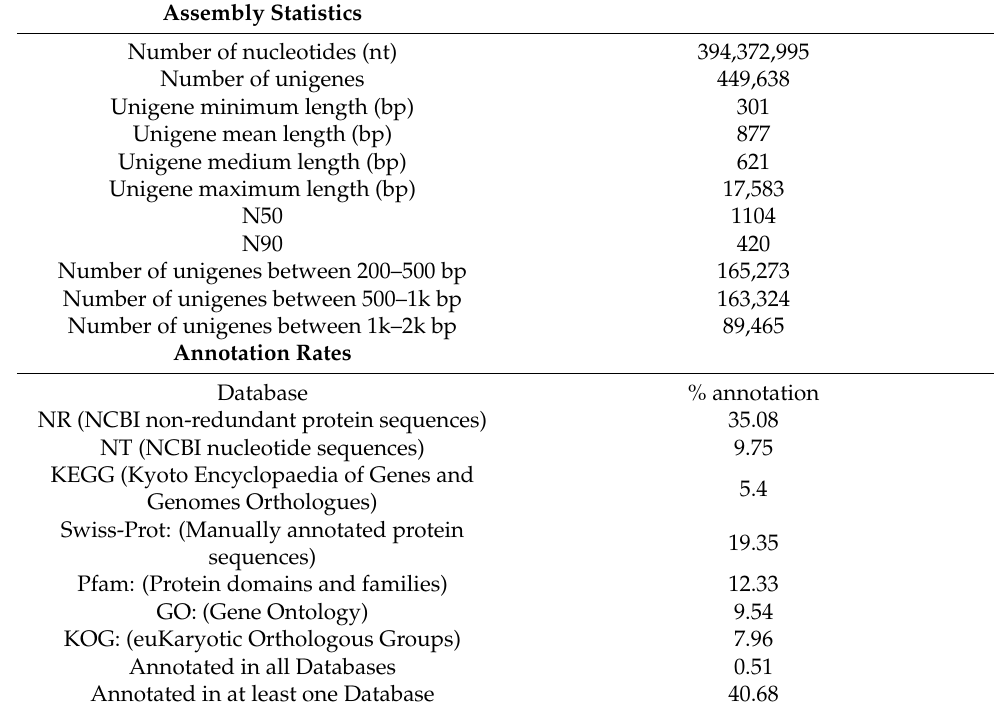
Table 1. Blue mussel ( M. edulis ) transcriptome assembly statistics and gene annotation